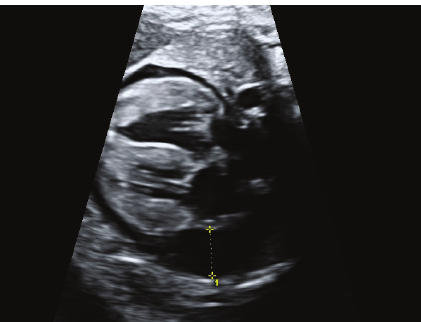
F 1: Fetal echocardiography at 37 weeks shows cardiac hypertrophic involving the right ventricular, le ventricular and interventricular septum, and pericardial effusion.